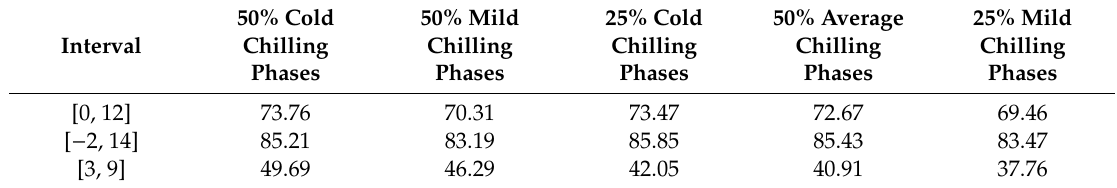
Table 3. Percentage of the total number of hours of e ff ective chill hours during the chilling phases (October, November, and December) of sets of cold or mild years as defined by the average temperature during the same months; e ffi cient temperature interval boundaries are given in ◦ C.